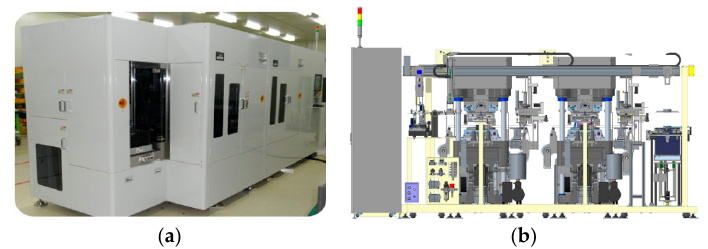
Figure 3. Components of compression molding.